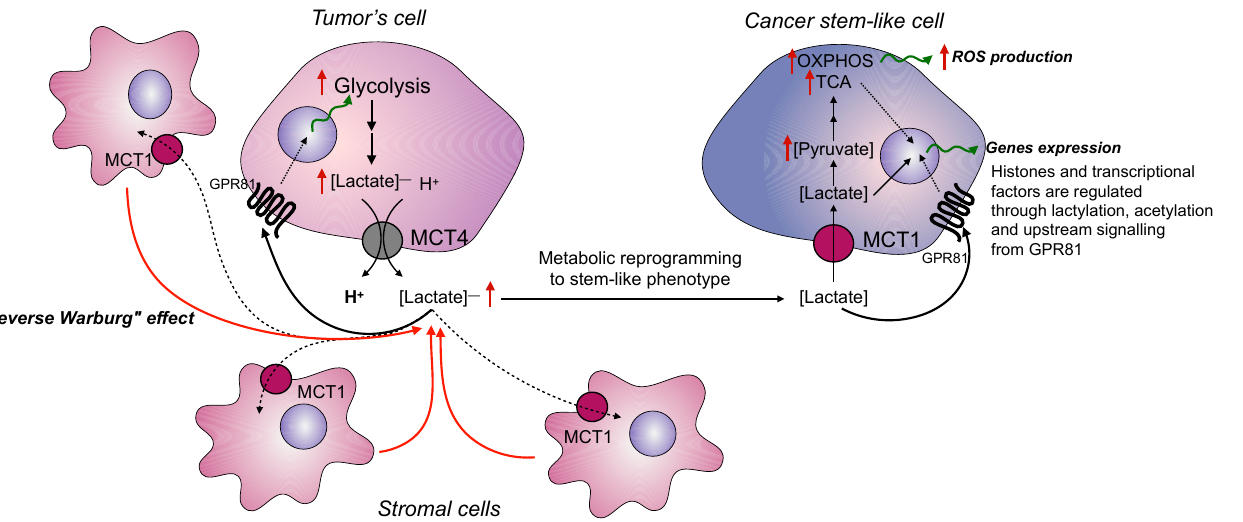
Figure 1. The role of lactate in cancer stem-like phenotype promotion. The accumulation of lactate in the TME leads to its metabolic reprogramming and affects the production of lactate by stromal cells (reverse Warburg effect). Furthermore, lactate may directly influence gene expression through the lactylation of histones and transcriptional factors.